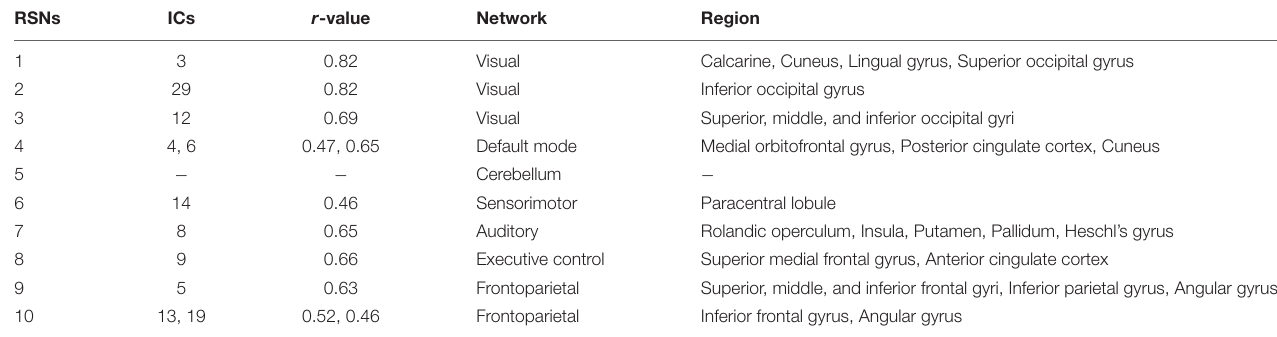
TABLE 2 | Functionally interpretable independent components (ICs) and resting state networks